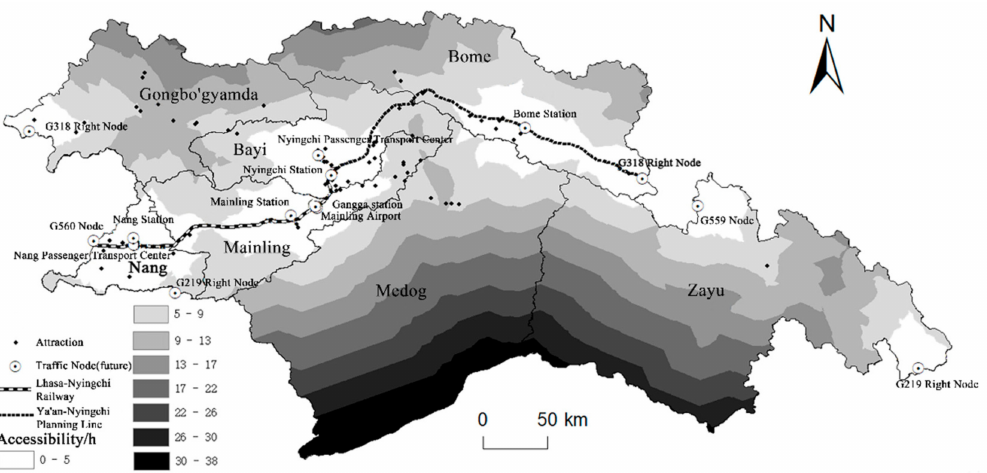
Figure 5. Future accessibility with traffic nodes as the core. Note: This map is based on the standard map of the Map Technical Review Centre of the Ministry of Natural Resources of China (Number: GS (2019)4342), with no modifications to the base map. Map-making by the author.